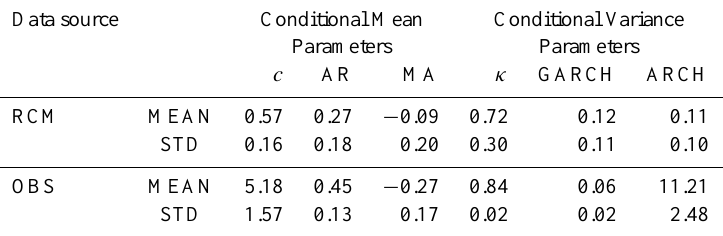
Table 2. Mean and standard deviation of the parameters for the fitted ARMA(1,1)-GARCH(1,1) models for selected stations (OBS) and their corresponding RCM grid cells (see Table 1 for further details about the stations). The conditional mean parameters of the ARMA model consist of c , the conditional mean constant, AR, the conditional mean autoregressive coefficient, and MA, the conditional mean moving- average coefficient. The conditional variance parameters consist of κ , the conditional variance constant, GARCH, the lagged conditional variance coefficient, and ARCH, the lagged residual coefficient.